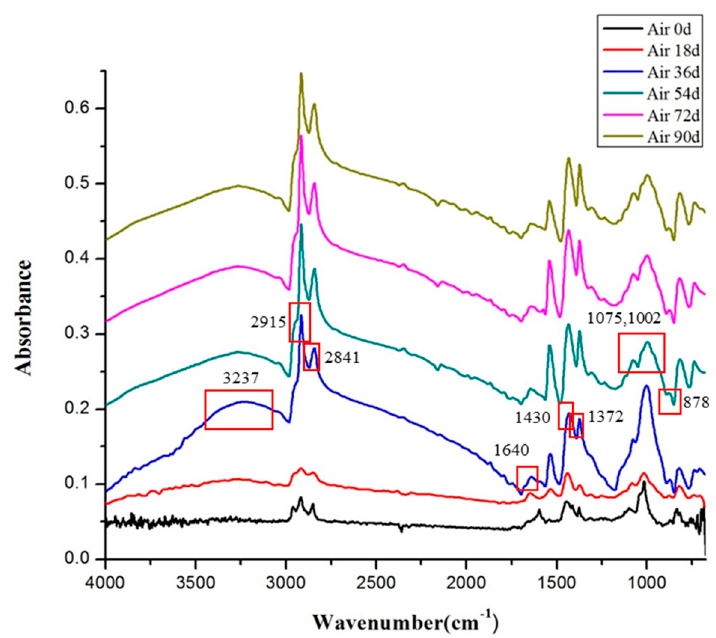
Figure 10. Infrared spectra of low-temperature air environment.